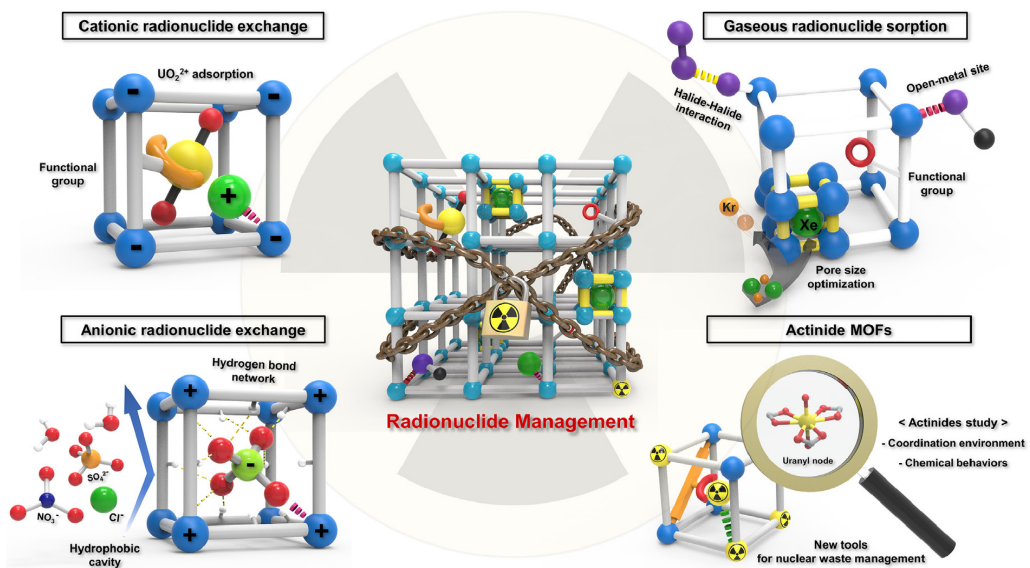
Figure 1. Schematic representation of applications of MOFs in radionuclide administration. The different color balls represent different atoms, the yellow ball is U, green ball is Xe and red ball is O. The other balls and sticks are mainly metal-organic frameworks (MOFs). Reprinted with permission from ref. [16]. Copyright 2021 Elsevier.